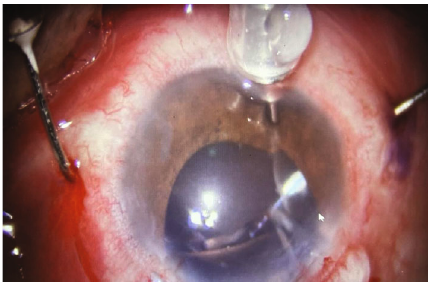
Figure 5: The haptics of the three-piece intraocular lens are derived from the inner scleral tunnel by inserting a double needle core, which is expanded by cauterization at the end and fi xed to the inner scleral layer.